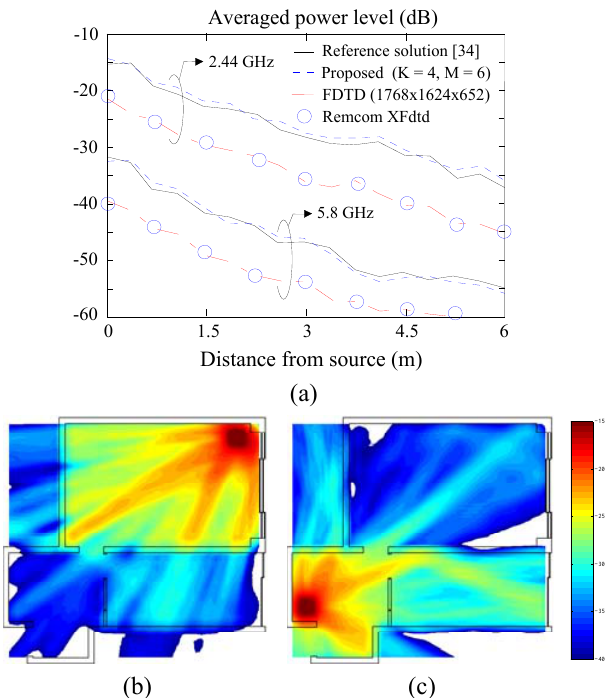
Figure 29: (a) Received power levels along the path of Fig. 28 and power-coverage maps at (b) 2.44 GHz and (c) 5.8 GHz. both the 2.44 GHz and the 5.8 GHz case are explored. To im- plement the proposed method, we select a = 0.031365, a = 1 2 = – 0.418721, and construct a grid with 388  342 0.950086, a 3  192 ≈ 25.5 million cells (about 1.27 GB). The corresponding FDTD discretization for a resolution of λ /25 requires a mesh of 1768×1624×652 ≈ 1.87 billion cells and around 67.32